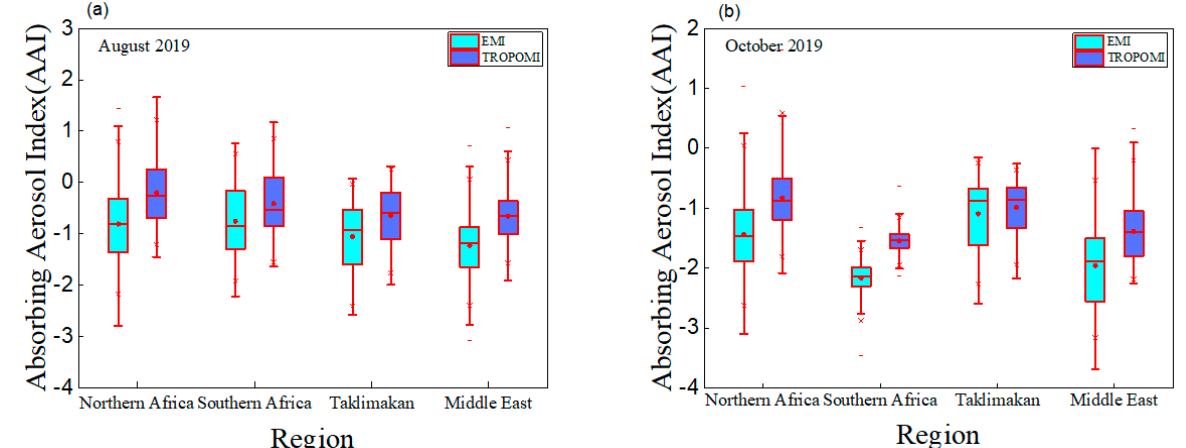
Figure 5. Box diagram of AAI from EMI and TROPOMI for August ( a ) and October ( b ) 2019 for four regions. Dots indicate monthly mean values. Lines on the AAI means the spread of the values (i.e., the maximum and minimum monthly averaged AAI).